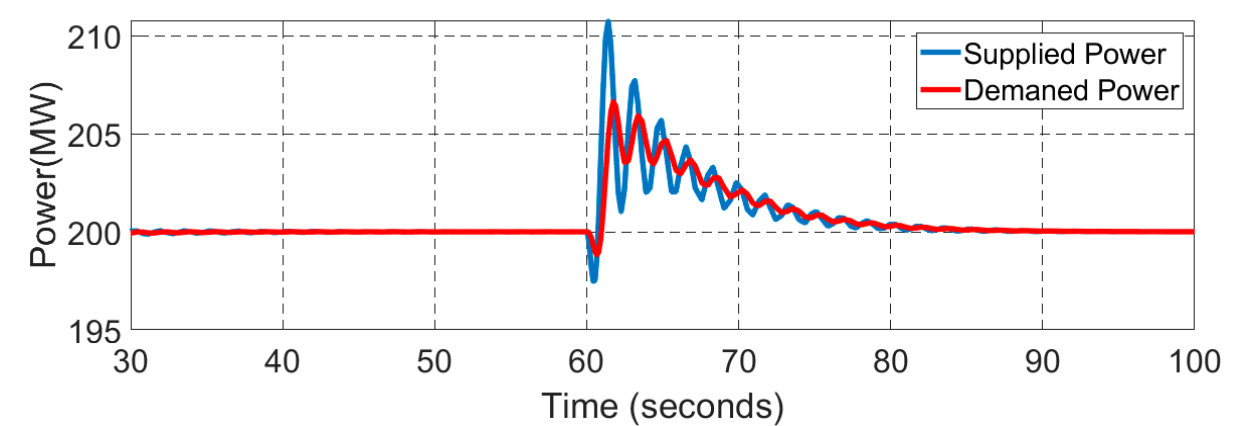
Figure 17. Step change load from 10% to 20% for a two-area PSN (Area 2): ( a ) frequency, ( b ) power.